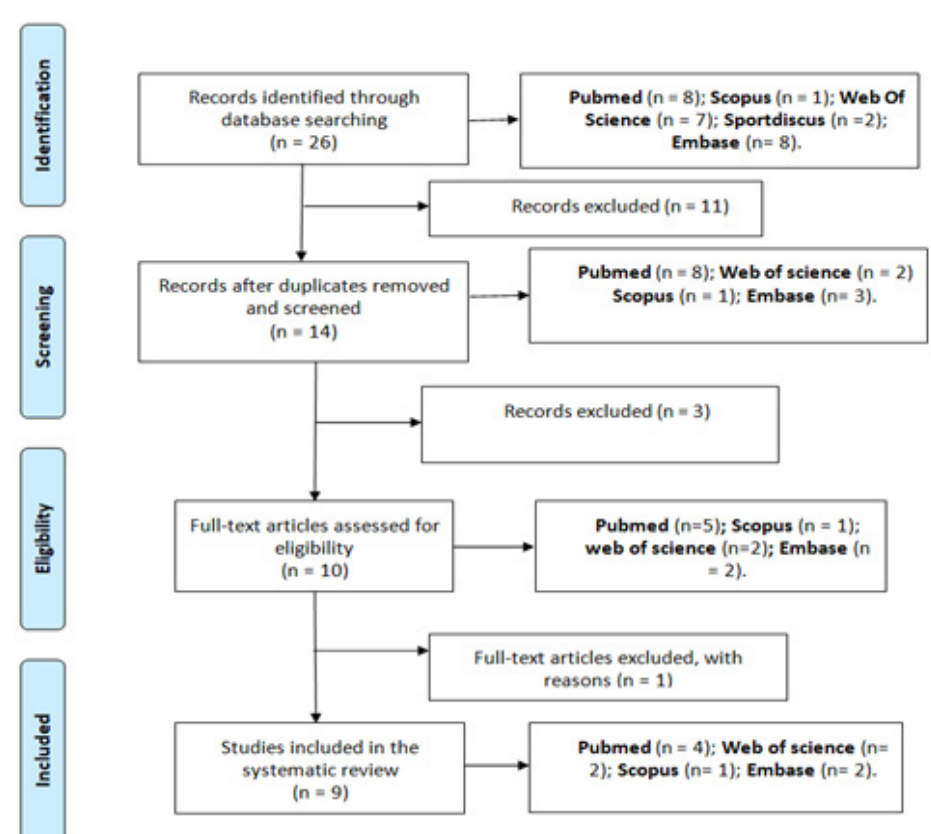
Figure 1. PRISMA (Preferred Reporting Items for Systematic Review and Meta-Analyses) diagram. The results obtained showed different study parameters in the approach to the proposed topic (Table 2). Table 2. Characteristics and main results of clinical trials on the use of probiotics in endurance athletes and improvement of sports performance.